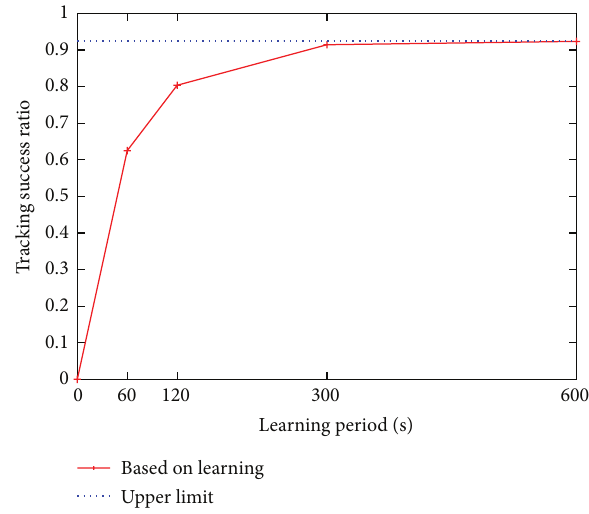
Figure 12: Tracking success ratio during a 3600s simulation period plotted against the learning